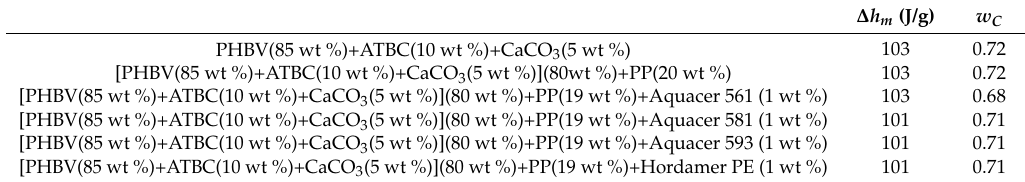
Table 4. Enthalpy of melting ( Δ h m ), and crystalline weight fraction ( w C ) of PHBV based matrix and